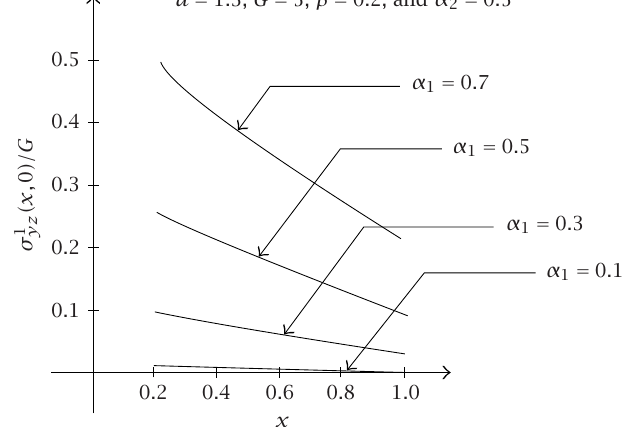
Figure 3.6 . Variation of σ 1 yz (x, 0 )/G α = 3 , 5 , 7 , 9, a = 1 . 3, G = 2, α 2